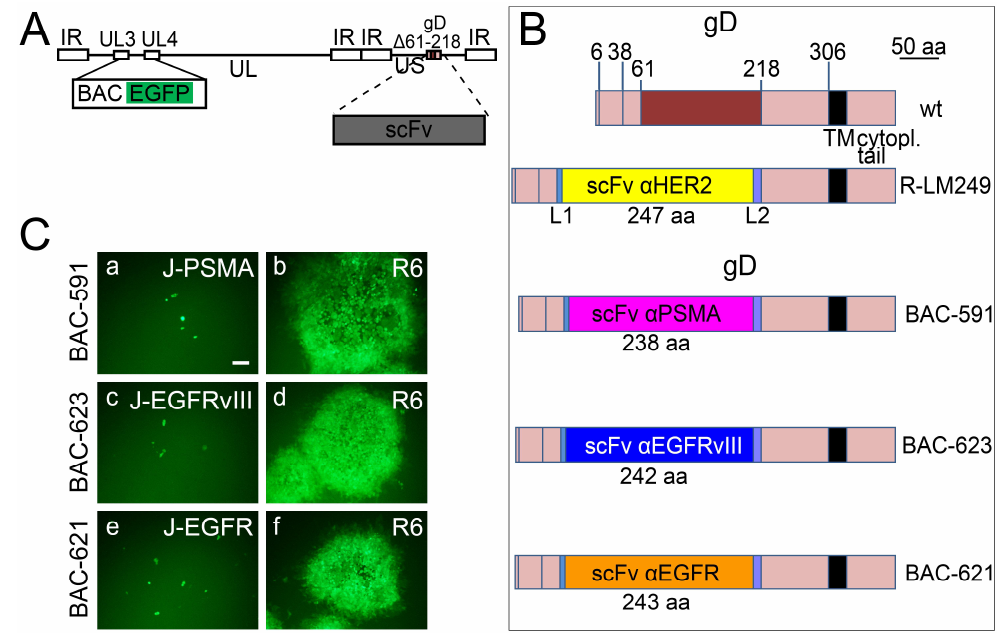
Figure 5. Failure to generate replication-competent recombinants by insertion of scFv in gD Δ61–218. ( A ) Schematic drawing of the recombinant genomes that carry the scFv in place of aa 61–218 of mature gD. pBeloBAC11 and EGFP (BAC EGFP) are inserted between UL3 and UL4 [50]. ( B ) Schematic linear maps of gD in recombinant BAC-591, BAC-623, and BAC-621 compared to wt gD. The aa coordinates relevant to this study are indicated. Scale bar, 50 amino acid residues. L1, L2, linker 1 and 2. ( C ) The recombinant genomes BAC-591, BAC-623, and BAC-621 carry non-functional recombinant gDs, and do not carry defects in genes other than gD. Transfection of BAC DNAs in R6 cells expressing wt-gD under the UL26.5 promoter allows the formation of plaques (panels b, d, f). Transfection of J cells expressing the individual target receptor only gives rise to single EGFP-positive cells (panels a, c, e). Pictures were taken at day 3 post transfection. The levels, brightness, and contrast of the panels were adjusted by means of Adobe Photoshop as follows: brightness +120, input level (black) 30, then again brightness +50, contrast +50. Scale bar = 100 μm.